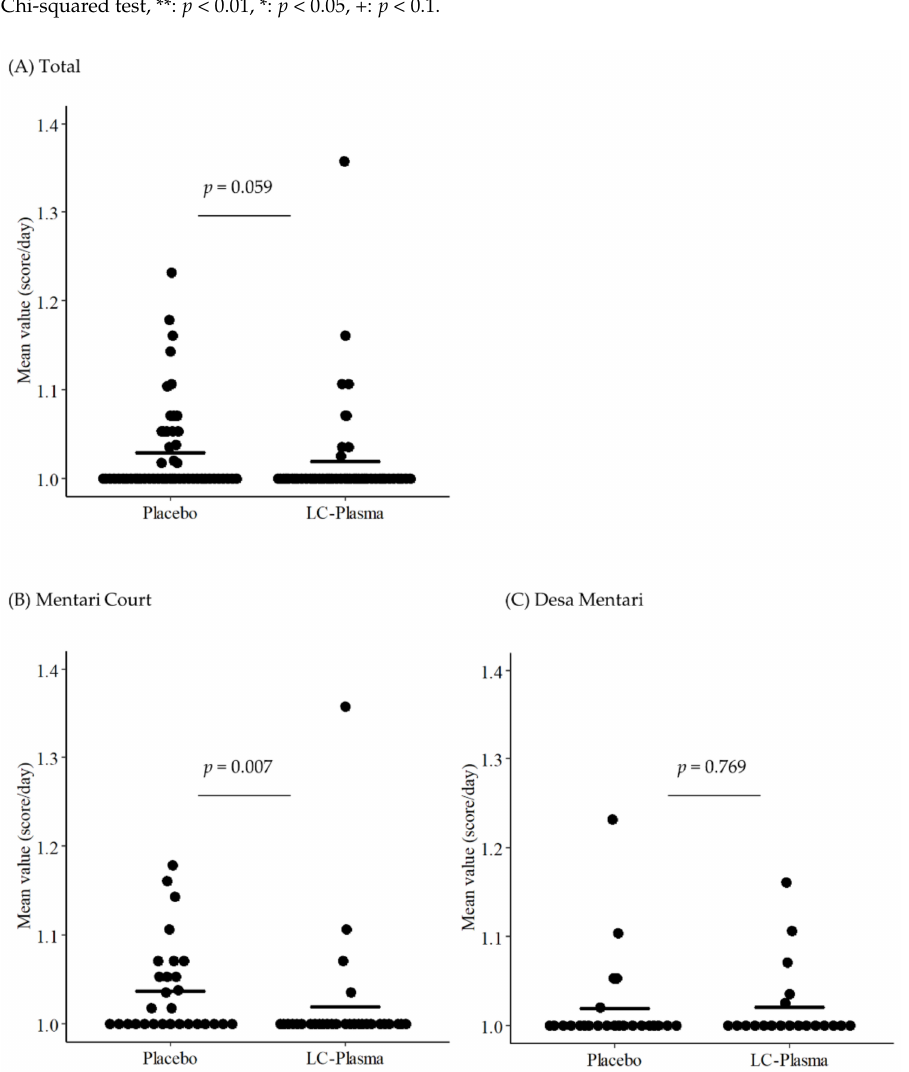
Figure 2. Suppression of fever scores by LC-Plasma supplementation among: ( A ) total participants, ( B ) Mentari Court participants, and ( C ) Desa Mentari